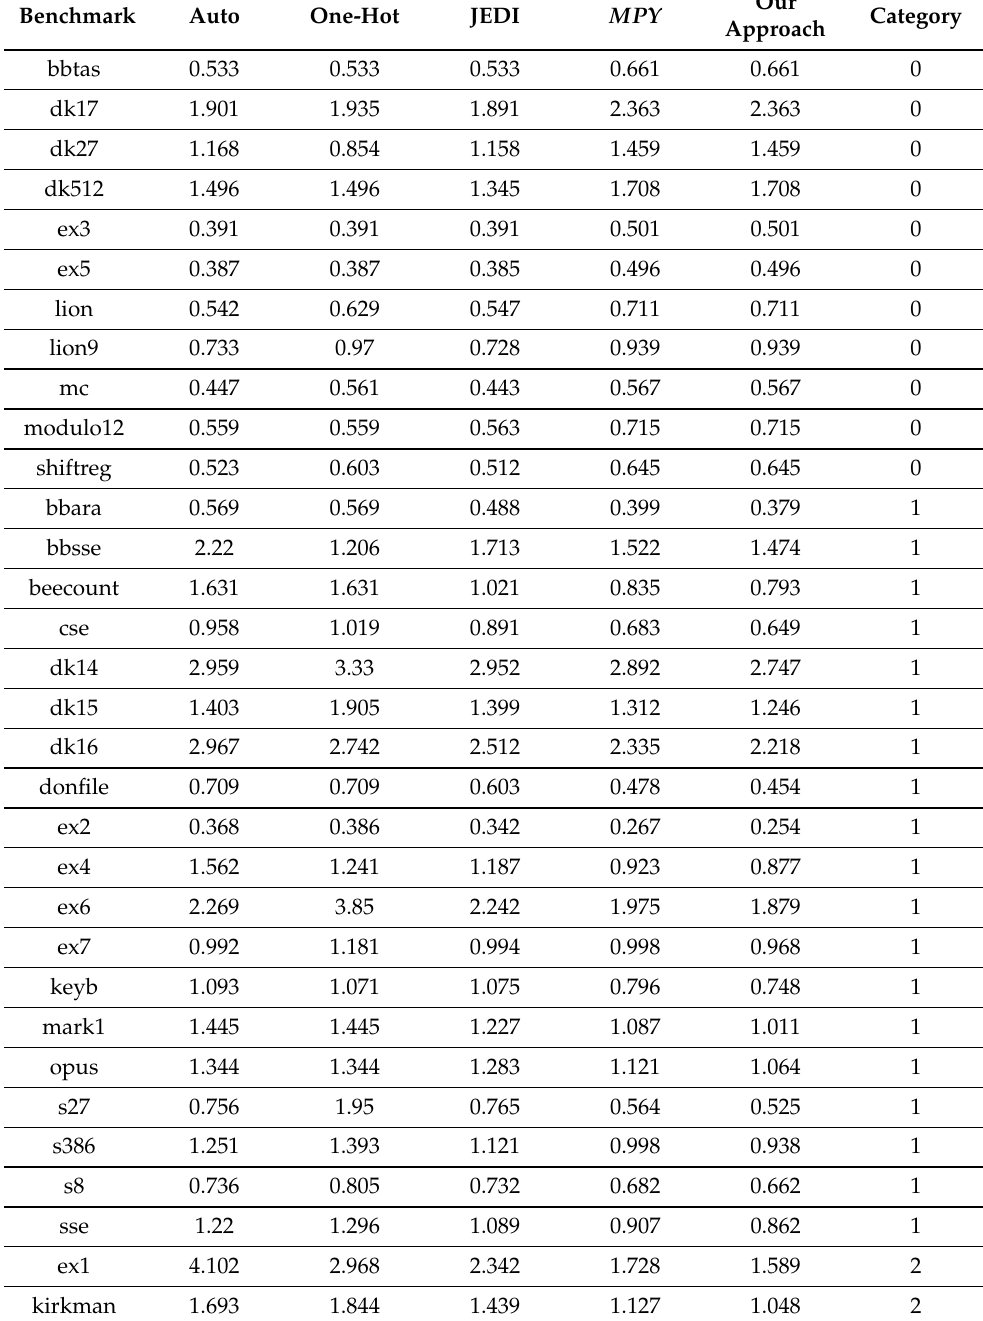
Table 11, we have compared area-time characteristics for each category of benchmark FSMs. As in the previous cases, for category 0 our approach gives the worst results; however, starting from category 1, the benefits of our approach are steadily increasing. Table 10. Experimental results (Total On-Chip Power,